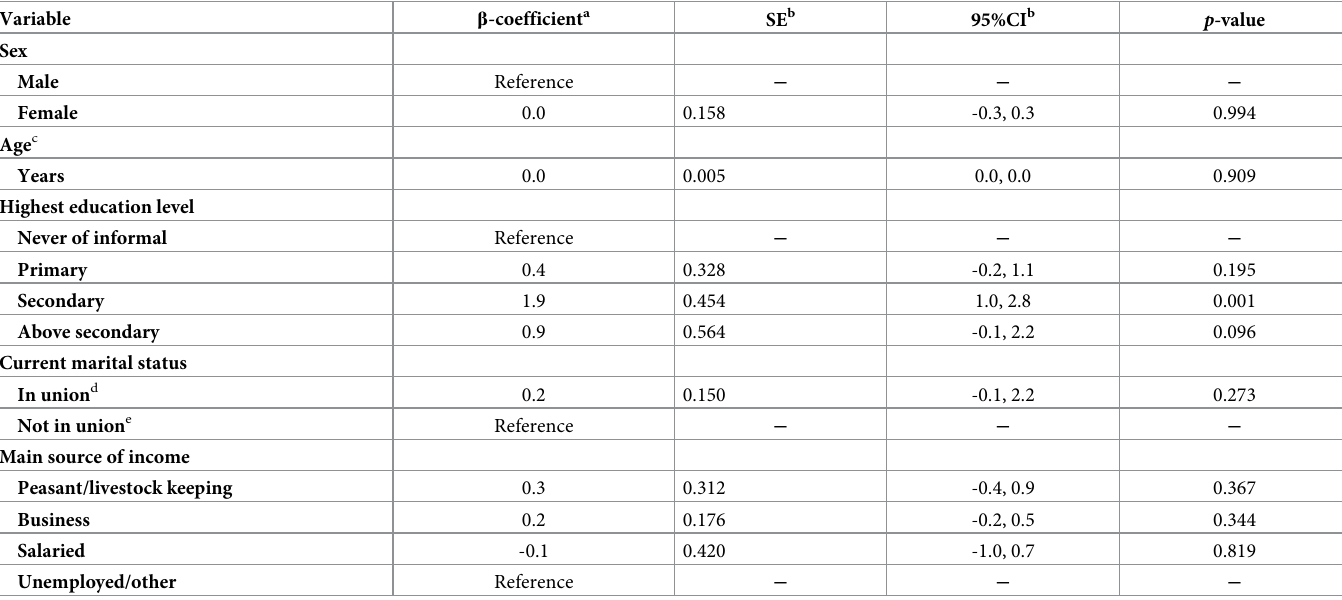
Table 3. Association of individual-level factors and overall knowledge scores on TB